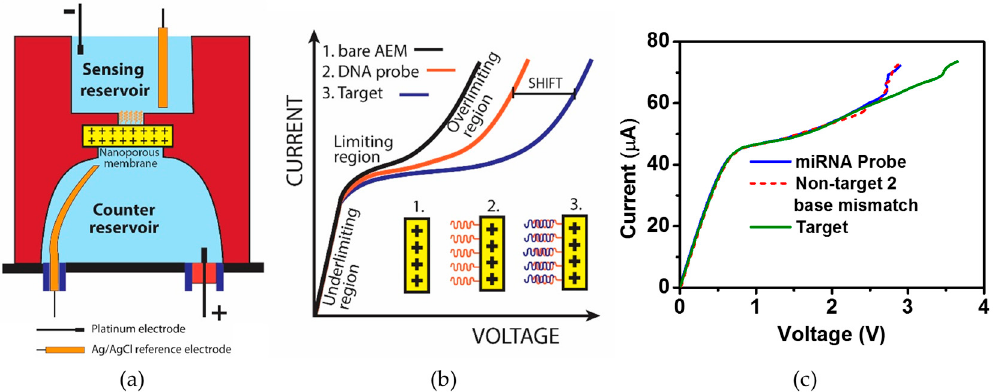
Figure 3. Sensing unit of the integrated platform. ( a ) Schematic showing the ion-exchange nanomembrane sensor; ( b ) Current-voltage characteristics (CVC) showing changes in ohmic, limiting and overlimiting regions for bare anion-exchange membrane (AEM; black), membrane functionalized with oligoprobe (red) and hybridization of DNA/RNA with oligoprobe (blue); ( c ) The specificity of the sensor was challenged by using a non-target sequence differing by only two base pairs compared to the target sequence. Change in CVC was only observed for the target miR sequence indicating the sensor’s capability to distinguish two-base-pair mismatches. Adapted with permission from [195].